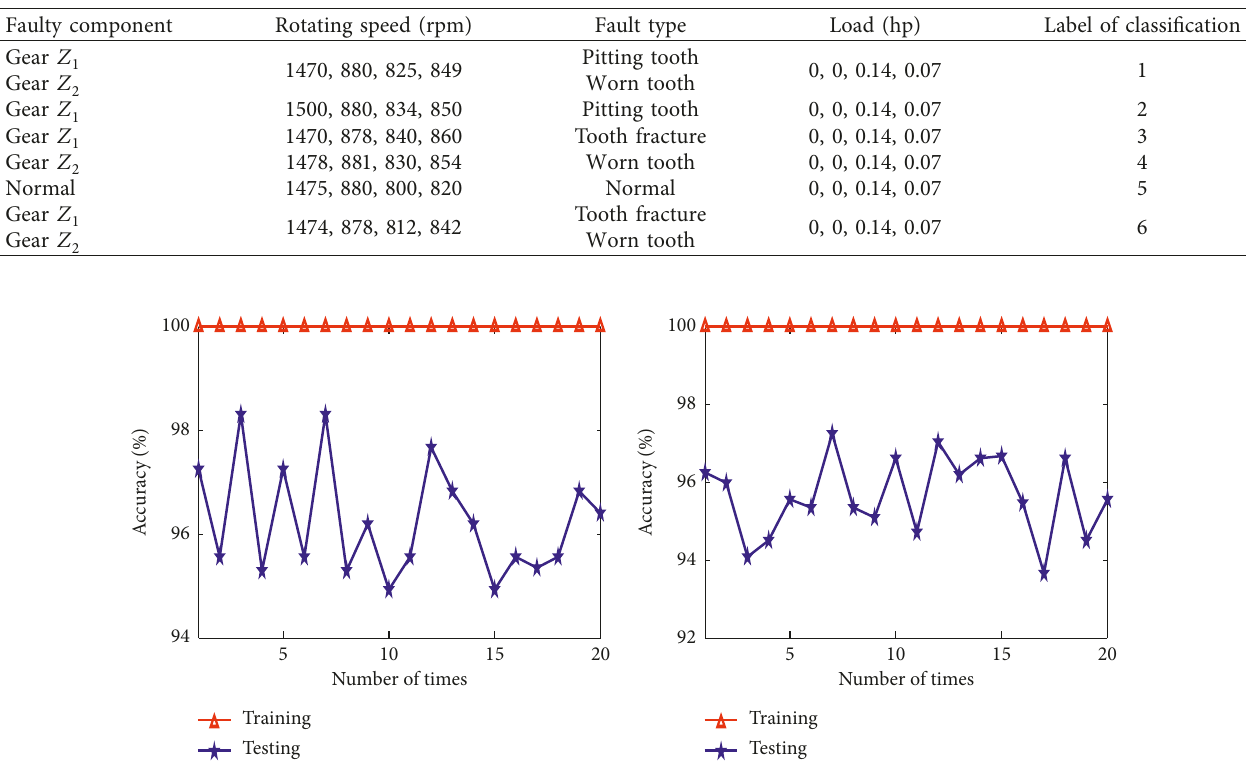
Table 1: Description of the dataset.